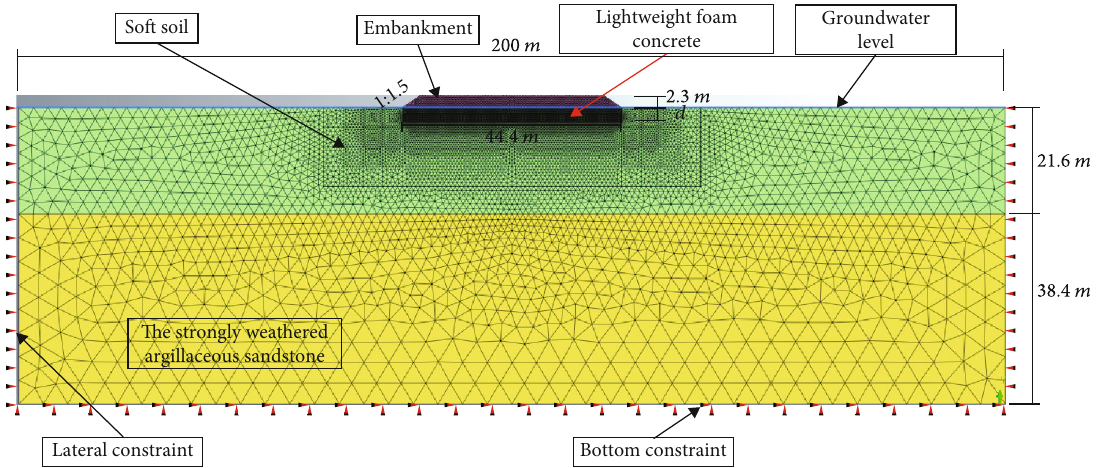
Figure 3: 2D fi nite element method model.